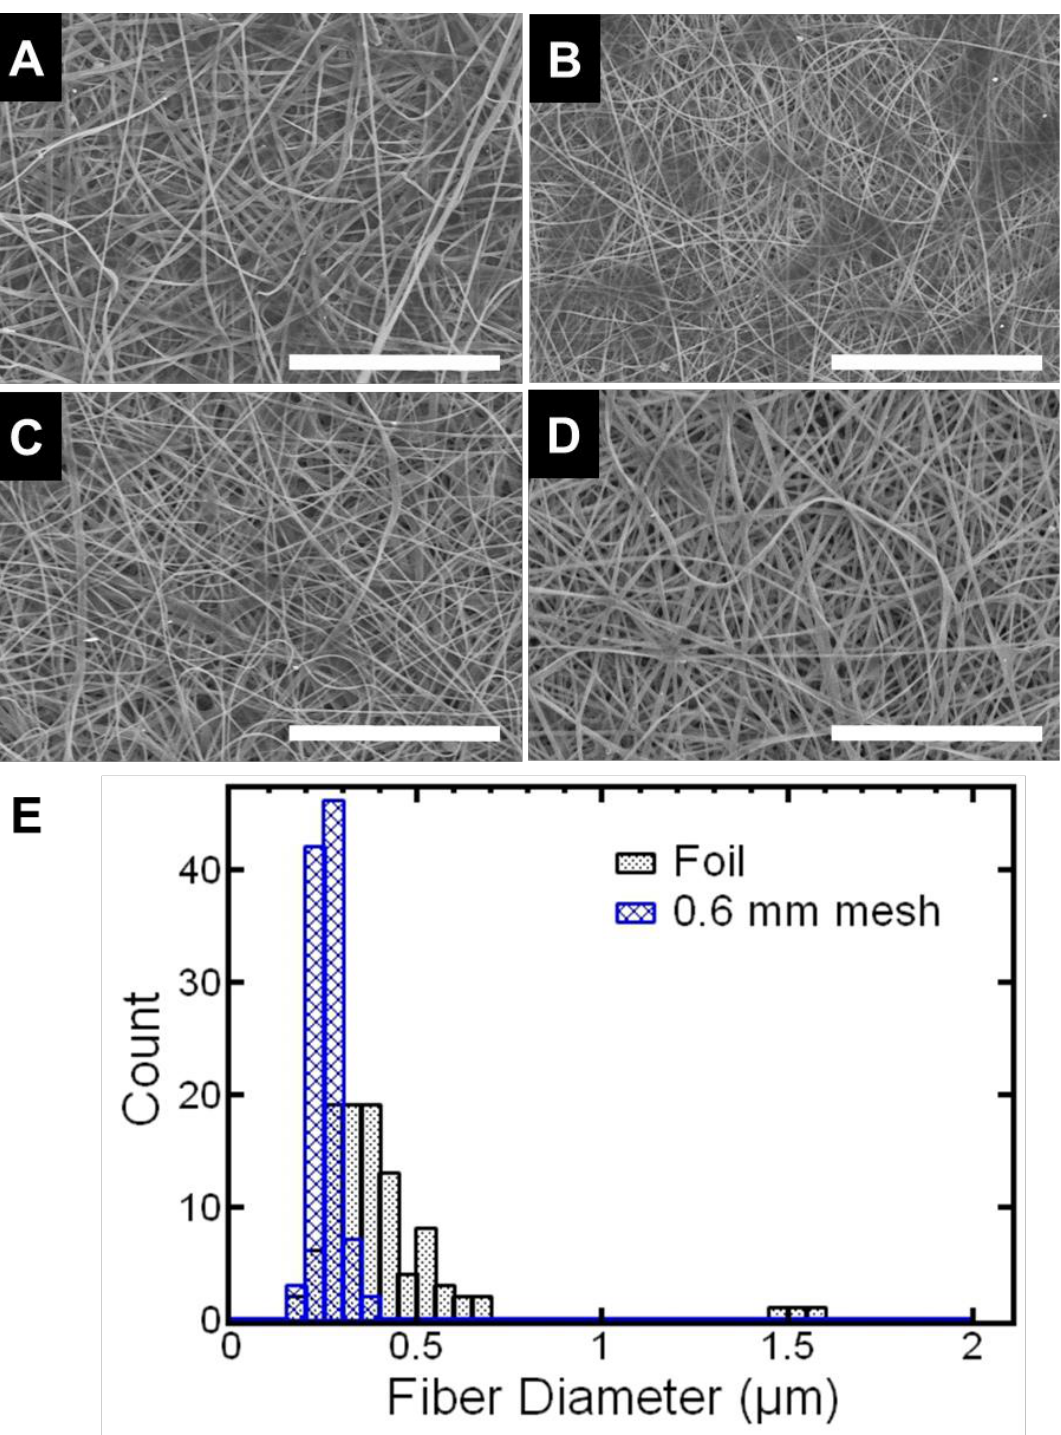
Figure 2. SEM micrographs at 5000× magnification to capture fiber diameter of the electrospun samples collected on ( A ) foil, ( B ) 0.6 mm mesh, ( C ) 0.9 mm mesh, and ( D ) 6 mm mesh. The scale bar represents 20 microns. Patterning generally decreases fiber size and narrows the fiber size distribution. The effect is most apparent when comparing the sample collected on foil and the sample collected on the 0.6 mm mesh. Fiber size distributions of both samples are shown in ( E